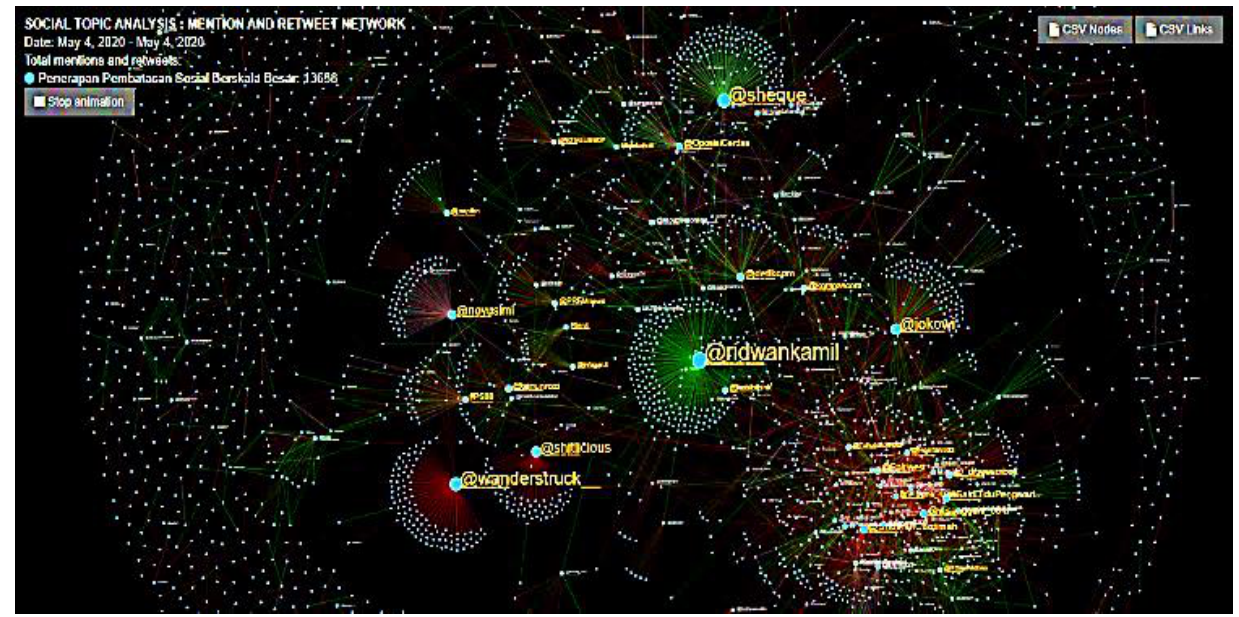
Figure 8. Social Network Analysis on 4 May 2020; the condition was recorded at 11:59 p.m.